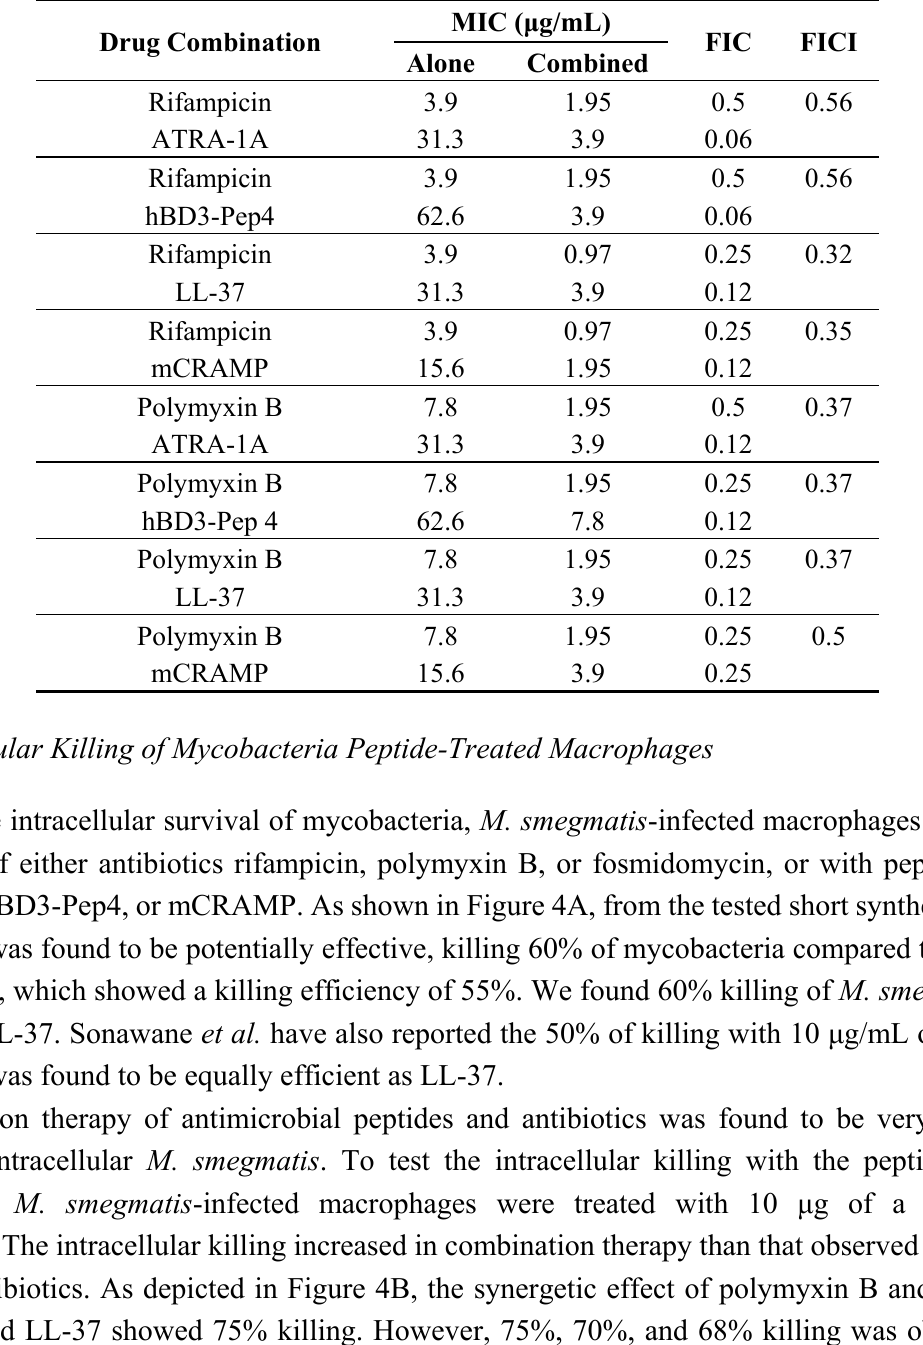
Table 4. Checkerboard assay of antibiotics and antimicrobial peptides against M. smegmatis . Rifampicin/polymyxin B and ATRA-1A/LL-37/mCRAMP. Synergy is defined as FICI ≤